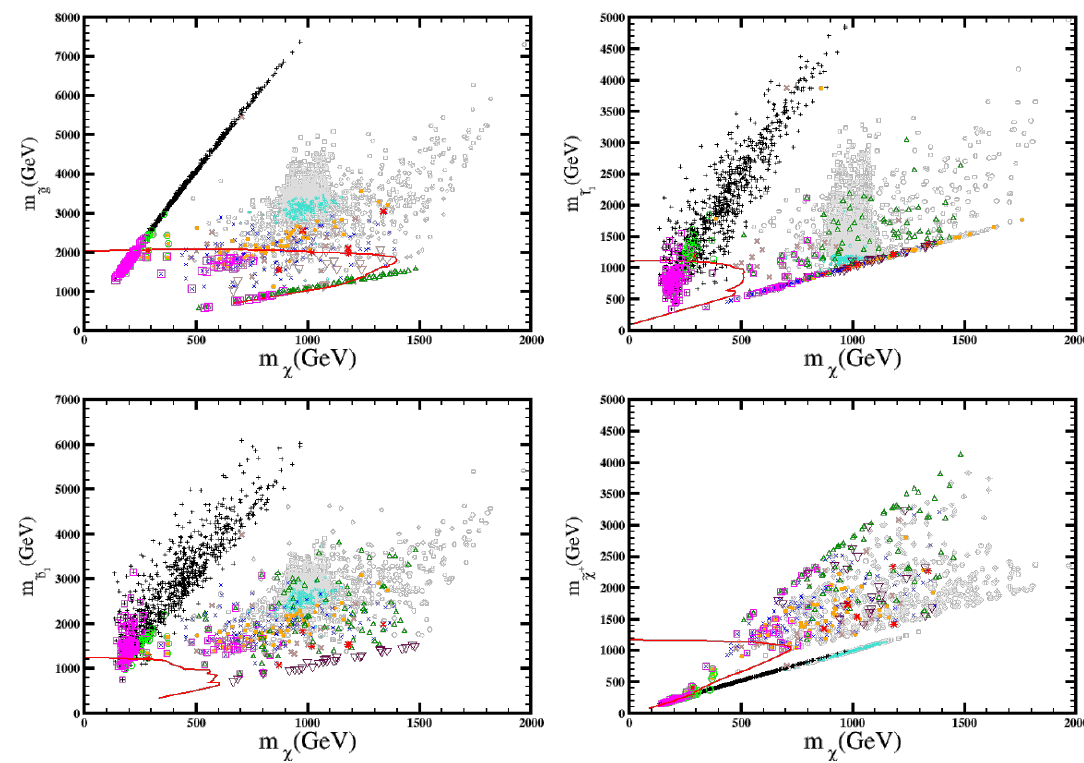
Figure 8 . The impact of the LHC searches on the 422 models from diverse bounds obtained by ATLAS and CMS. For the points we use the same code as in (cid:12)gure 1. The solid red line corresponds to the CMS bound applied to simpli(cid:12)ed SUSY scenarios while the points in the purple squares are excluded by the same bounds applied to the predictions of our models using